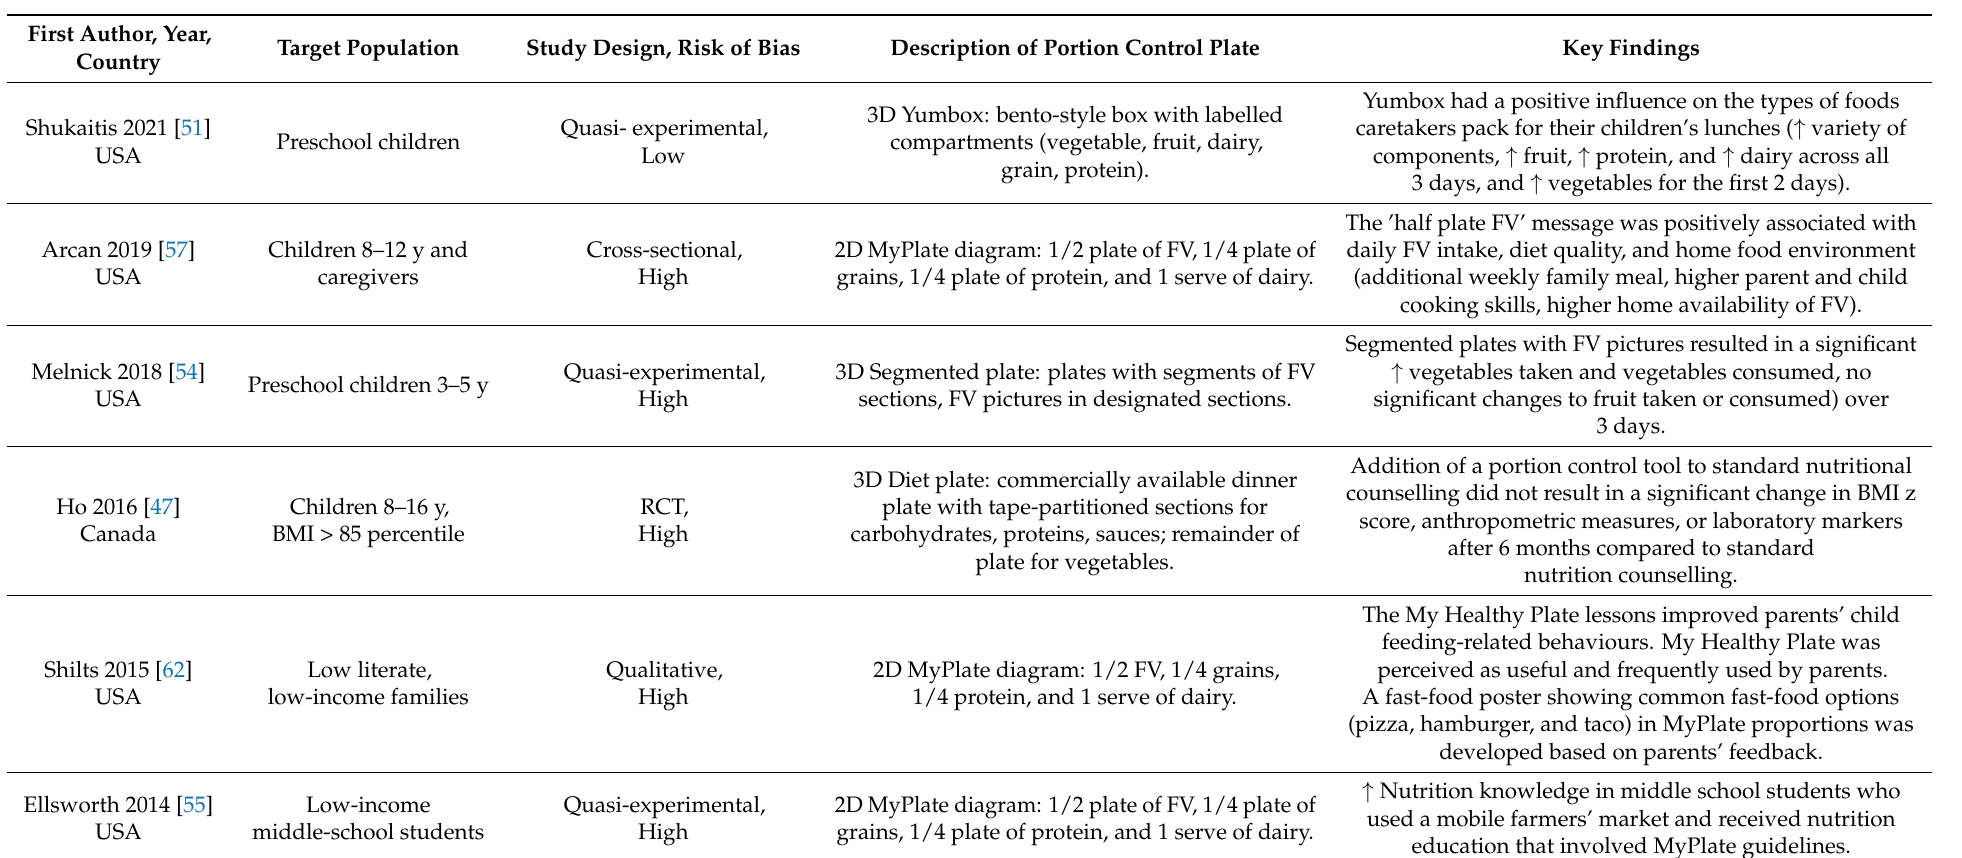
Table 2. Studies reporting changes in nutrition knowledge and dietary behaviours in children and